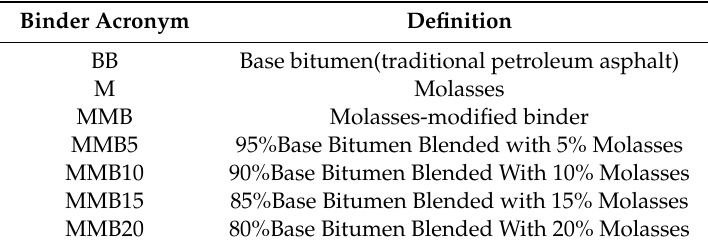
Table 2. Asphalt binder sample range matrix and definition.